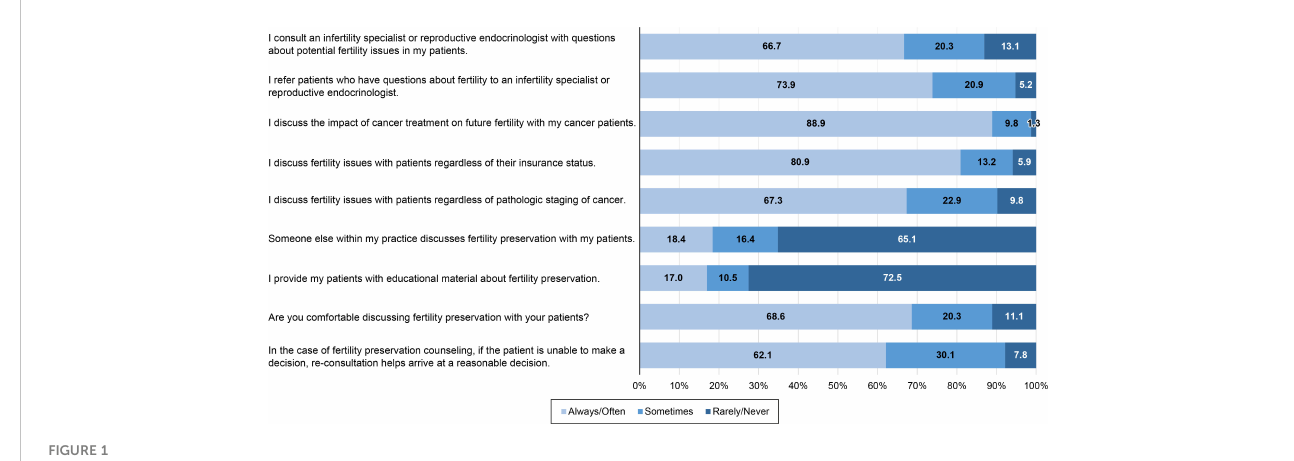
FIGURE 1 Fertility preservation practice